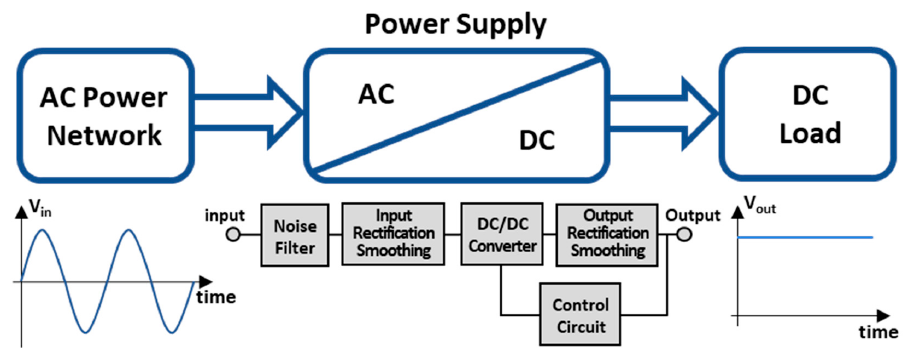
Figure 8. Simplified block diagram of an AC/DC converter operating and its functional